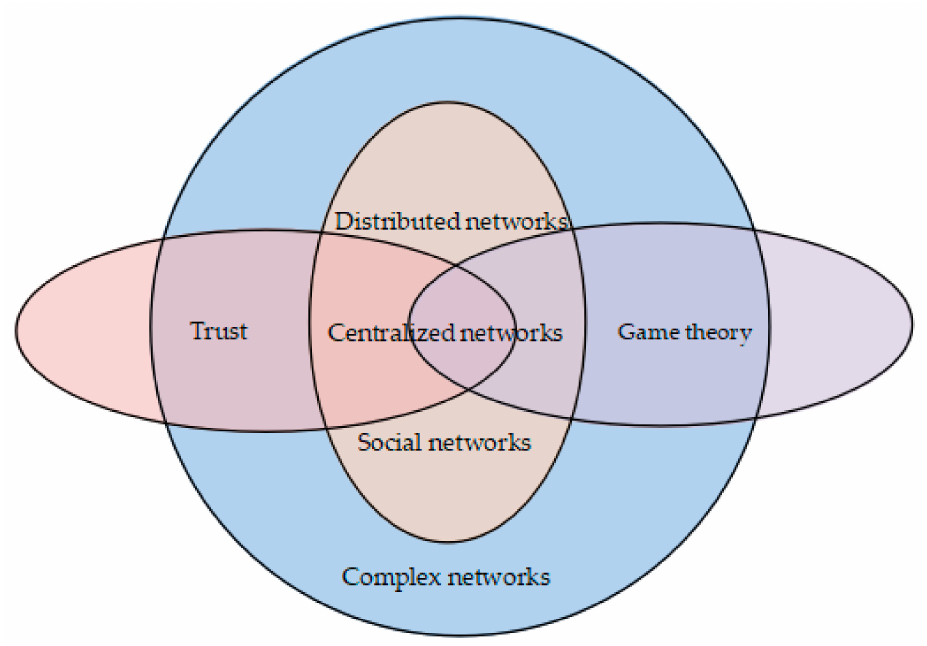
Figure 1. The relations between complex network, trust, and game